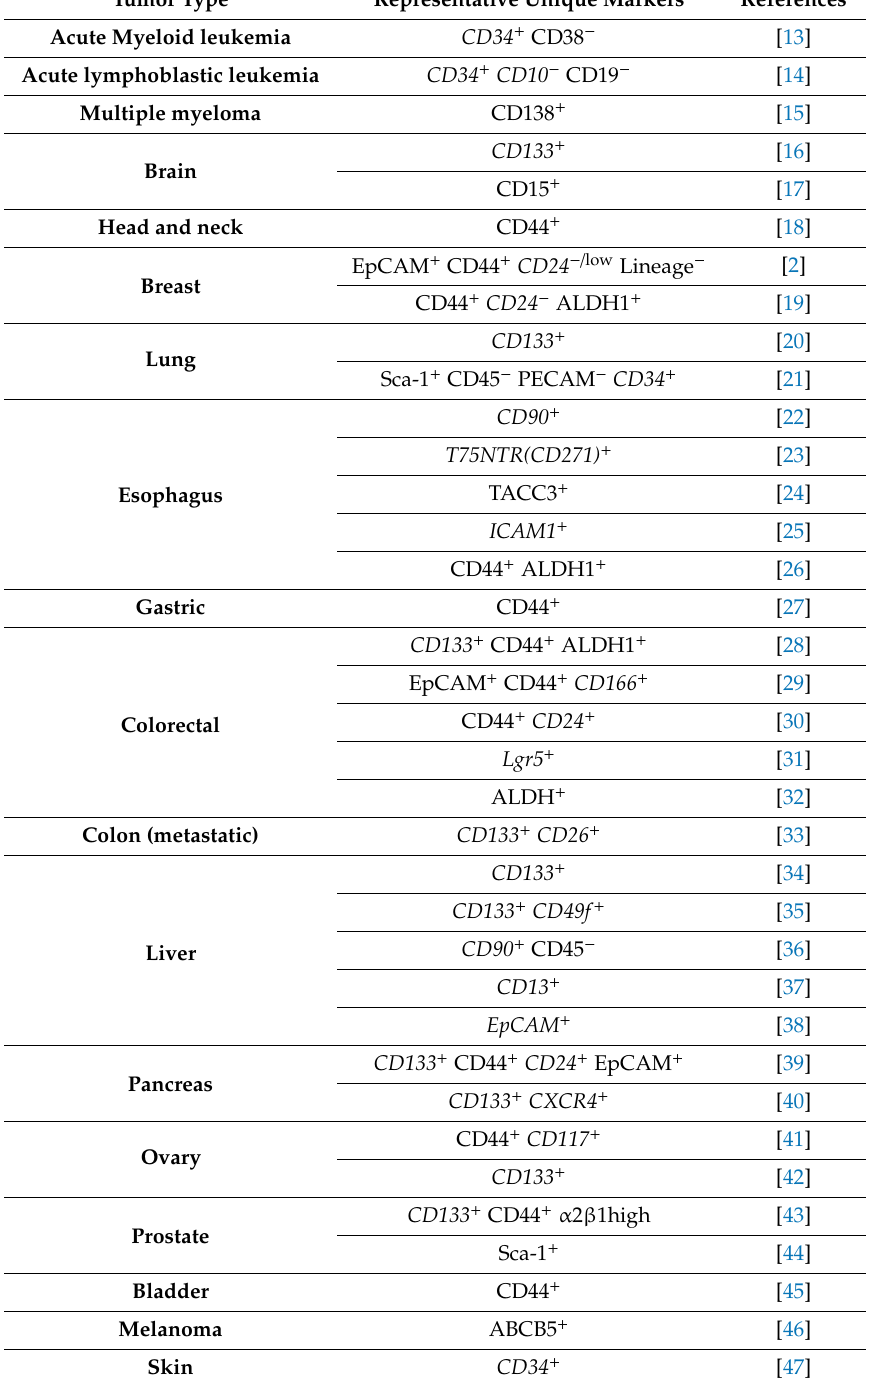
Table 1. Representative unique markers of cancer stem